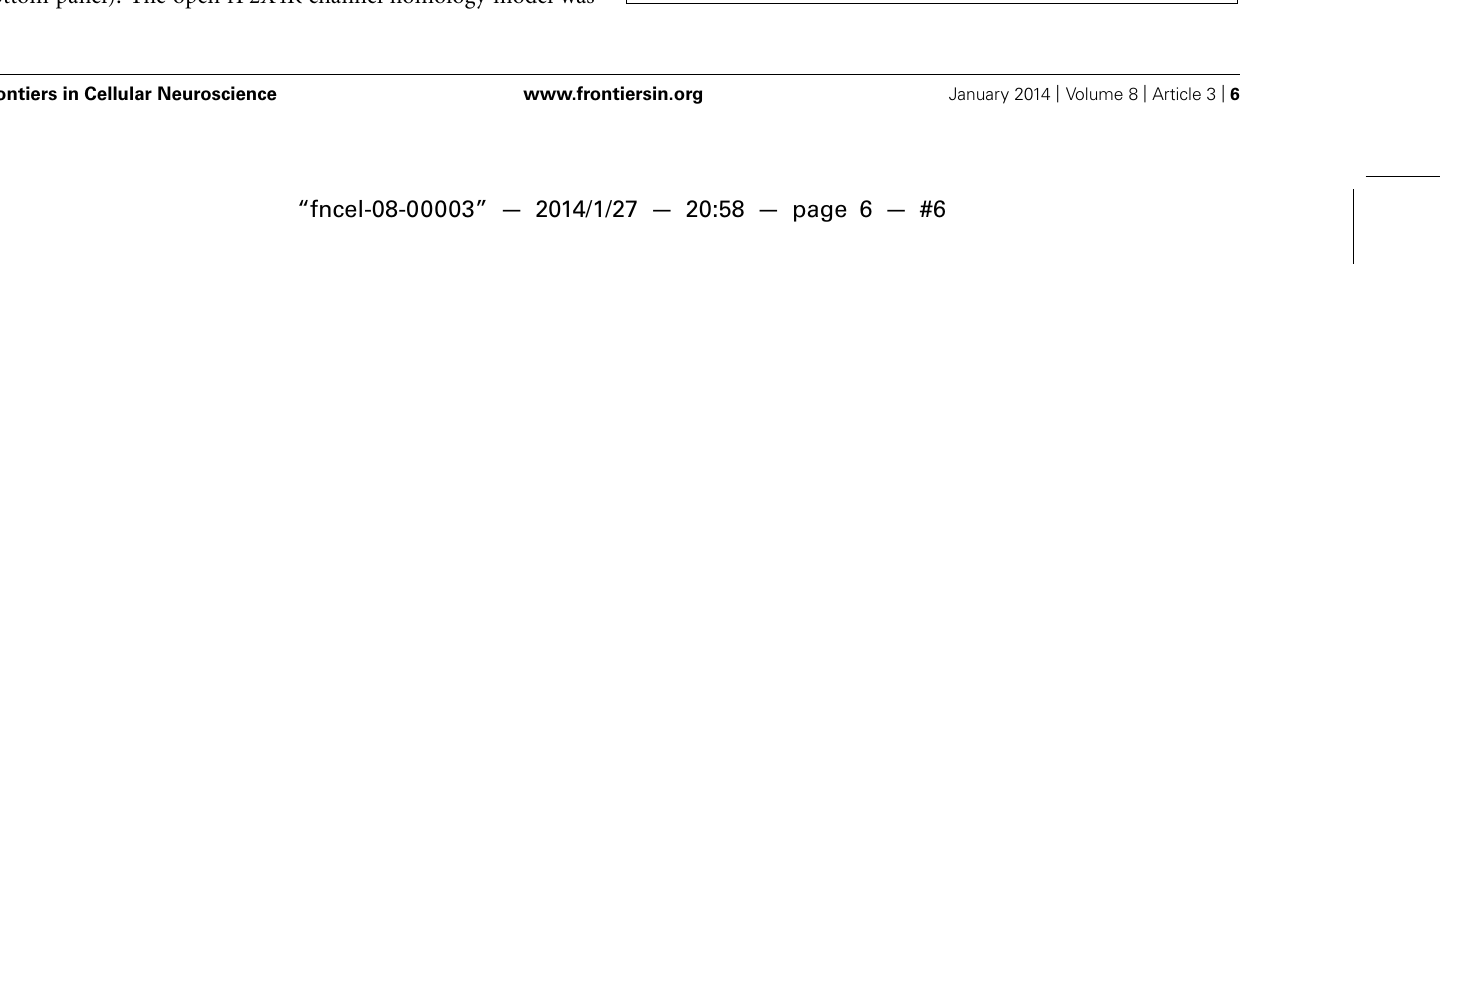
FIGURE 5 |Topology of cadmium-affected residues in the homology model of rP2X4R. Left panel represents a wire frame model of the rP2X4R polypeptide backbone with residues fromV47–V61 and K326–N338 (spheres) in closed (A) and open (B) state. Orange spheres depict the residues in cysteine mutants that were affected by cadmium in both states. Cadmium-inhibited residue mutants are depicted by red spheres and potentiated residue mutants are depicted by blue spheres. On the right panels the front subunit was removed for better visibility of the vestibule